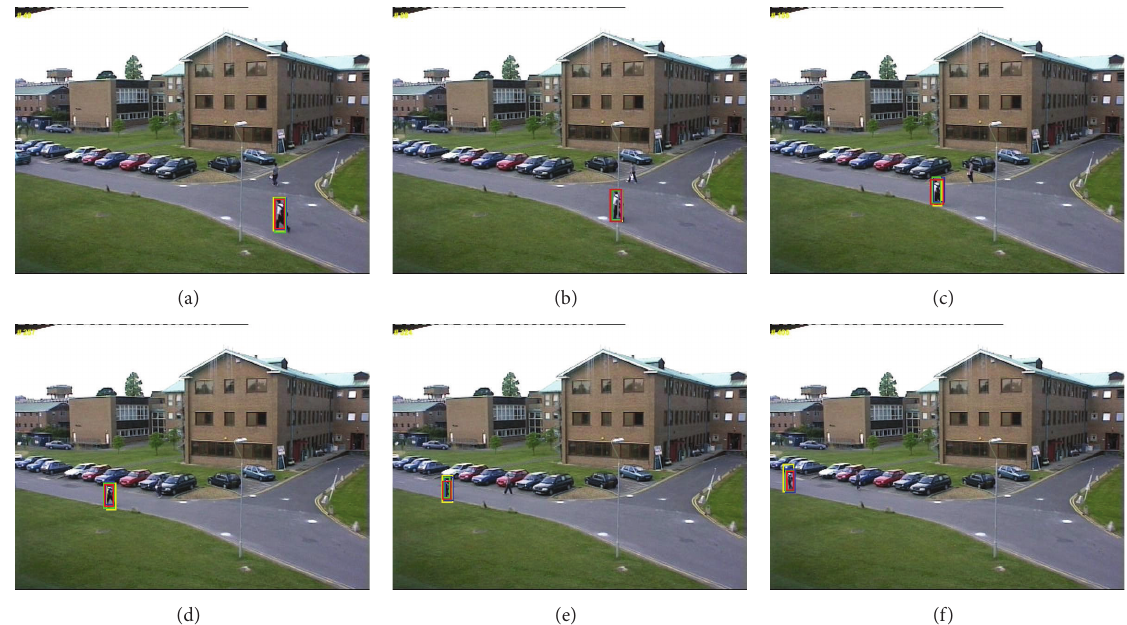
Figure 5: Tracking results of the PETS01D1Human1 sequence (MIL is yellow, IVT is blue, L1 is green, and our tracker is red).